Question: Is the quantity shown trending increasing or decreasing?
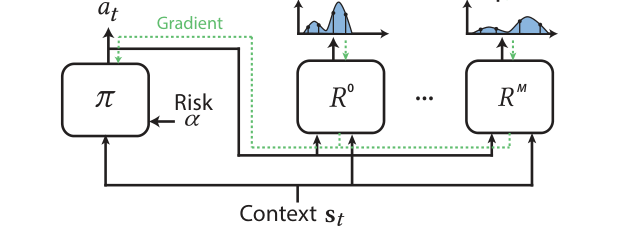
Answer: increasing